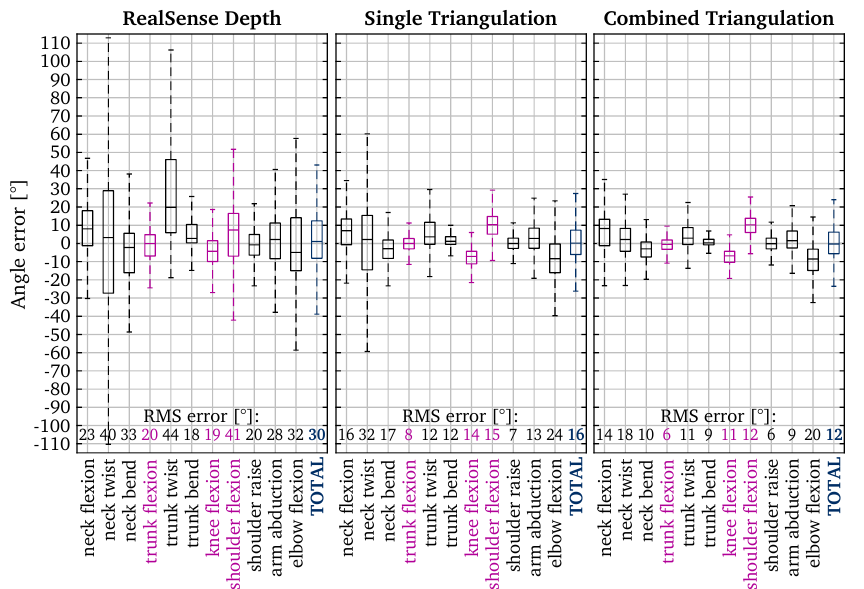
Figure 7. Error of calculated angles compared to the VICON ground truth. The key angles (joint angles with a high impact on the REBA score) are shown in